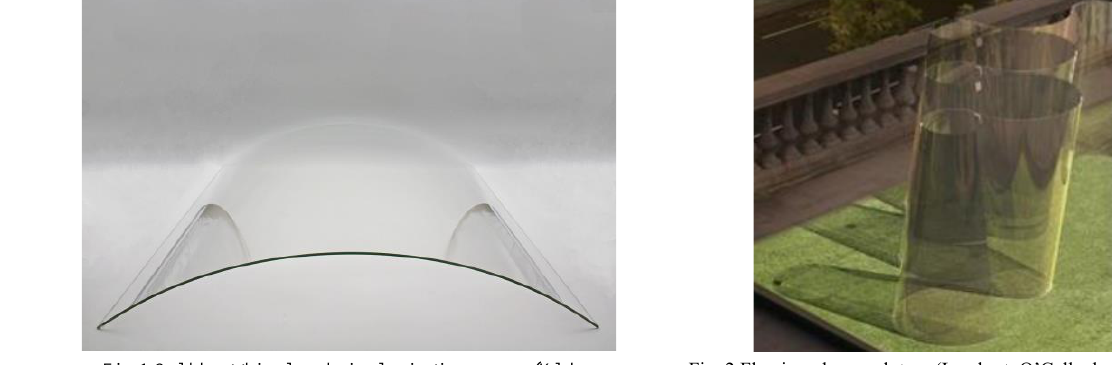
Fig. 1 Cold-bent thin glass during lamination process (Kloker 2012, © seele).